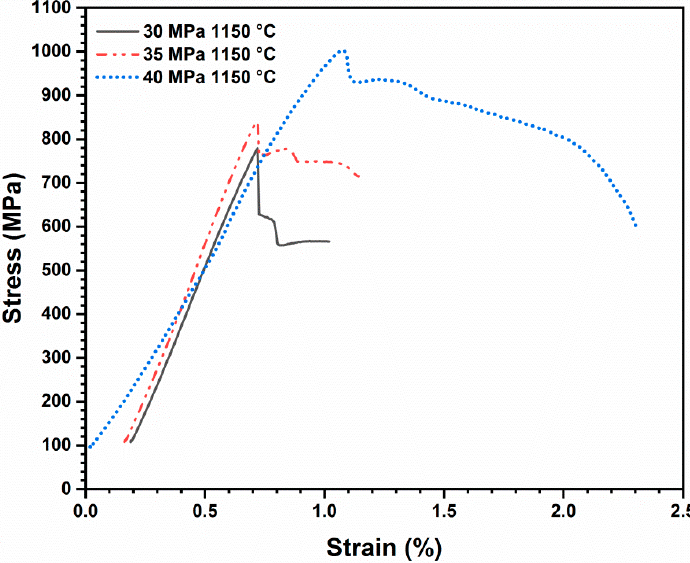
Figure 8. Bending curve of the HEA sample SPS processed under different pressure.